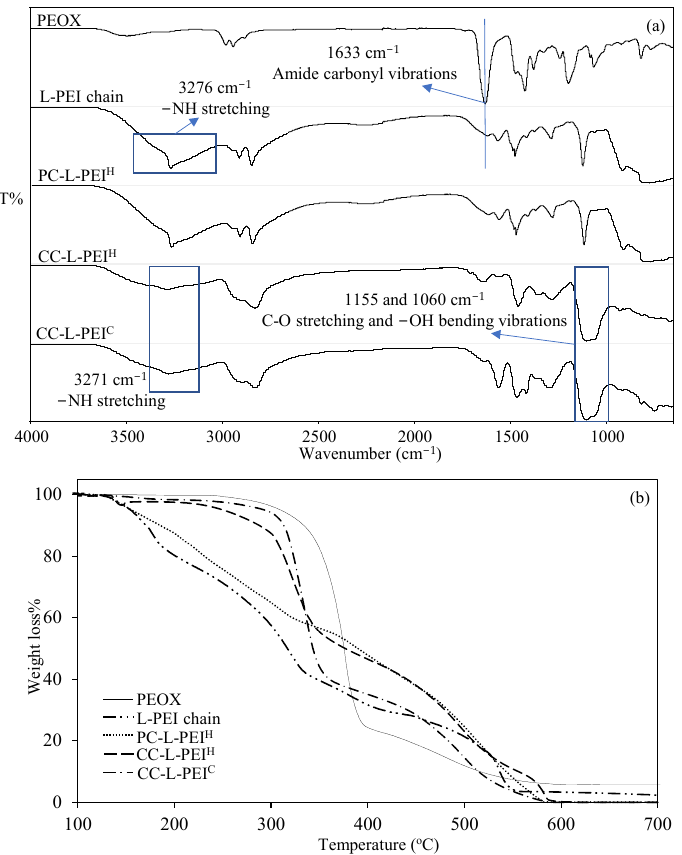
Figure 2. The comparison of ( a ) the FT − IR spectrum and ( b ) the TGA thermograms of PEOX, L-PEI chains, and L-PEI-based hydrogels and